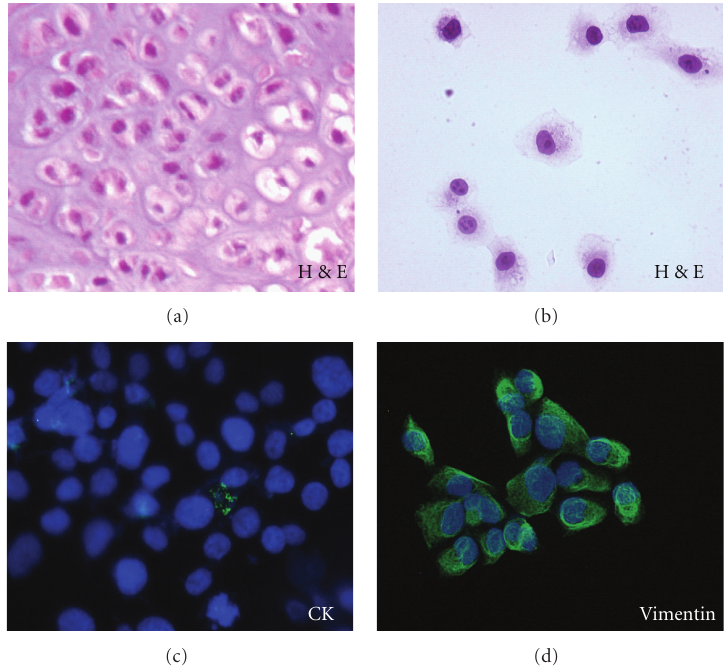
Figure 3: Immunophenotyping of chondrosarcoma cells. (a, b) haematoxilin/eosin stained chondrosarcoma cells resemble in shape and size those of chondrosarcoma tissue section. (c, d) chondrosarcoma cells grown on glass slides to semiconfluence were stained with anti- cytokeratin (CK) or anti-vimentin mAbs and with Alexa 488-conjugated F(ab’)2 fragment of rabbit anti-mouse IgG (green). Nuclei were stained blue with DAPI. Original magnification: